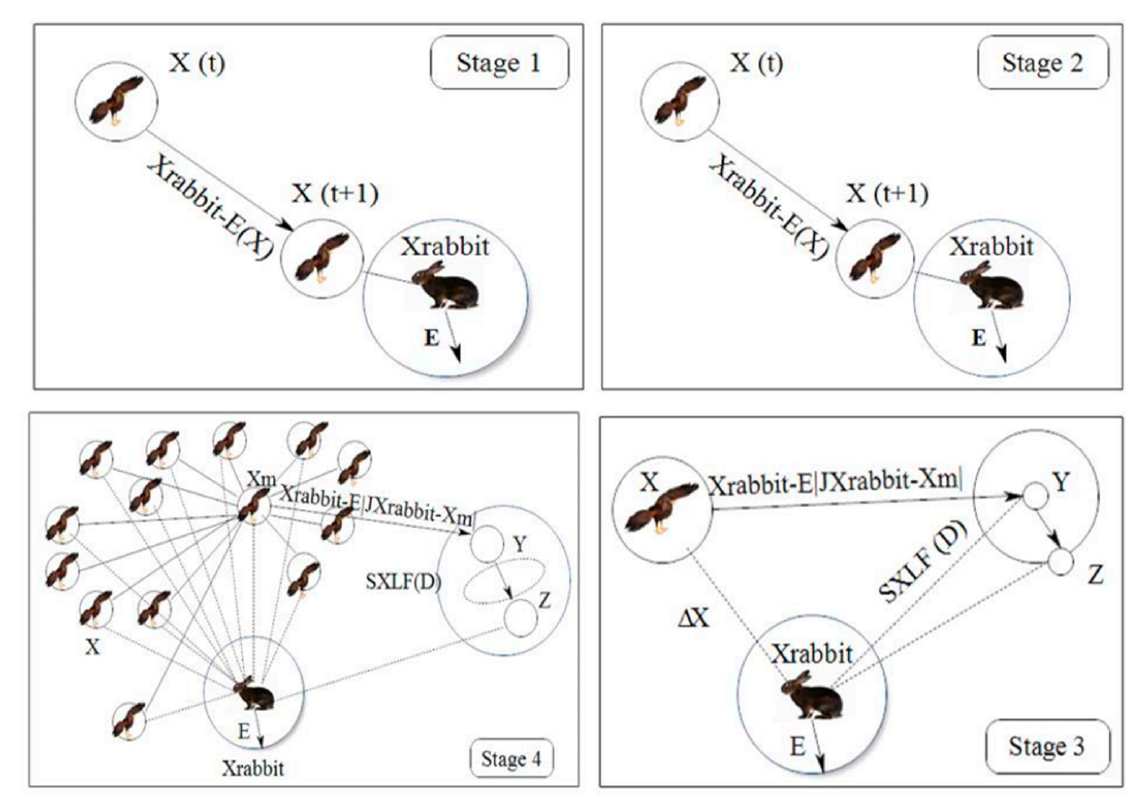
Figure 2. Different stages of Harris hawks optimization [31].